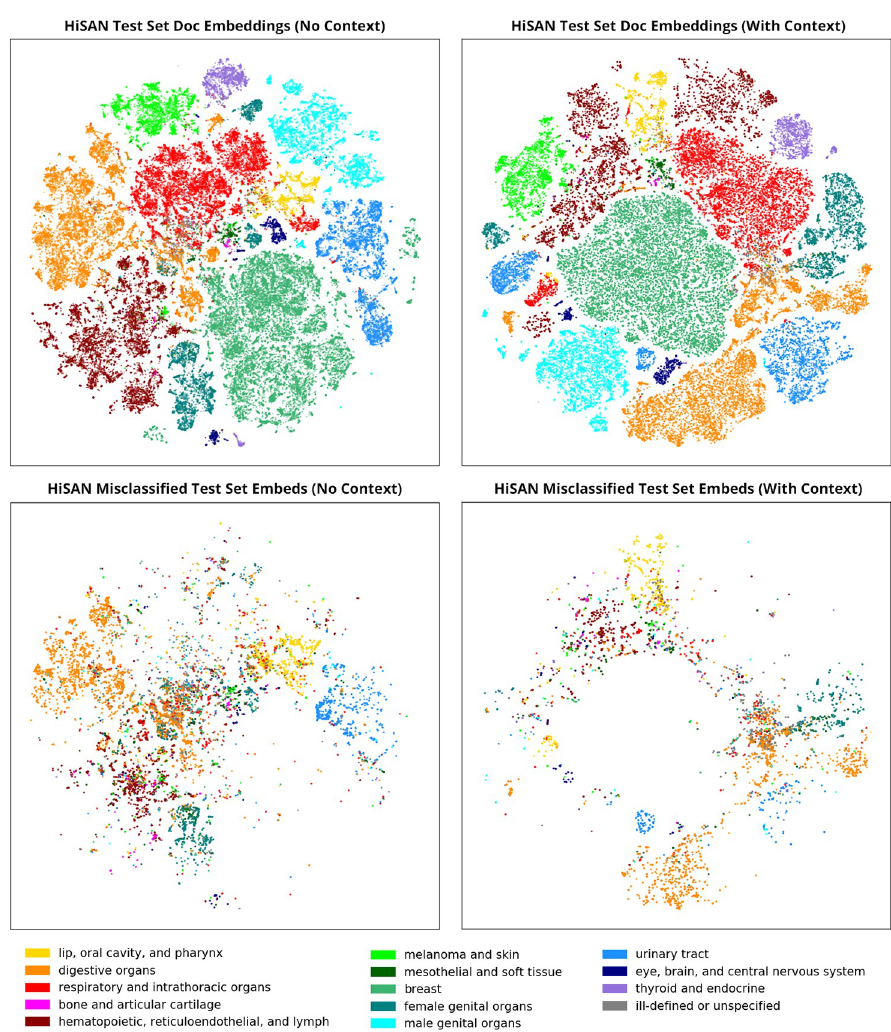
Fig 2. The top two subfigures show the cancer site document embeddings generated by the HiSAN for each pathology report in our test set with and without the self-attention module for capturing case-level context. The bottom two figures only show the document embeddings of misclassified reports in our test set. All document embeddings are colored by the ground truth organ system and visualized using t-SNE. The bottom pair of subfigures show only the document embeddings of misclassified reports in the test set, colored by the ground truth organ system. This visualization allows us to better general types of errors: (1) within-cluster misclassifications, in which the misclassified report